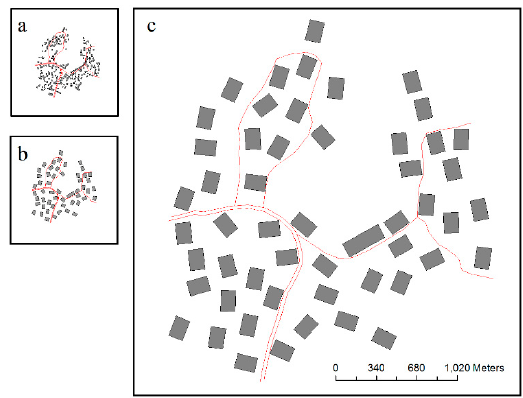
Figure 20. Test results of selection unit B: ( a ) visual reduction without selection (1:25,000), ( b ) selection result using the GA (1:25,000), and ( c ) selection result enlarged to 1:10,000 from 1:25,000.